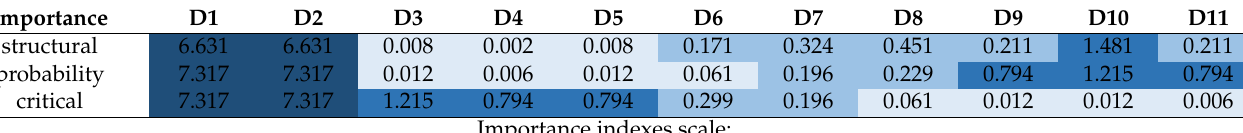
Figure 6. Bayes fire risk assessment index topological network. Table 3. Netica index simplification form.